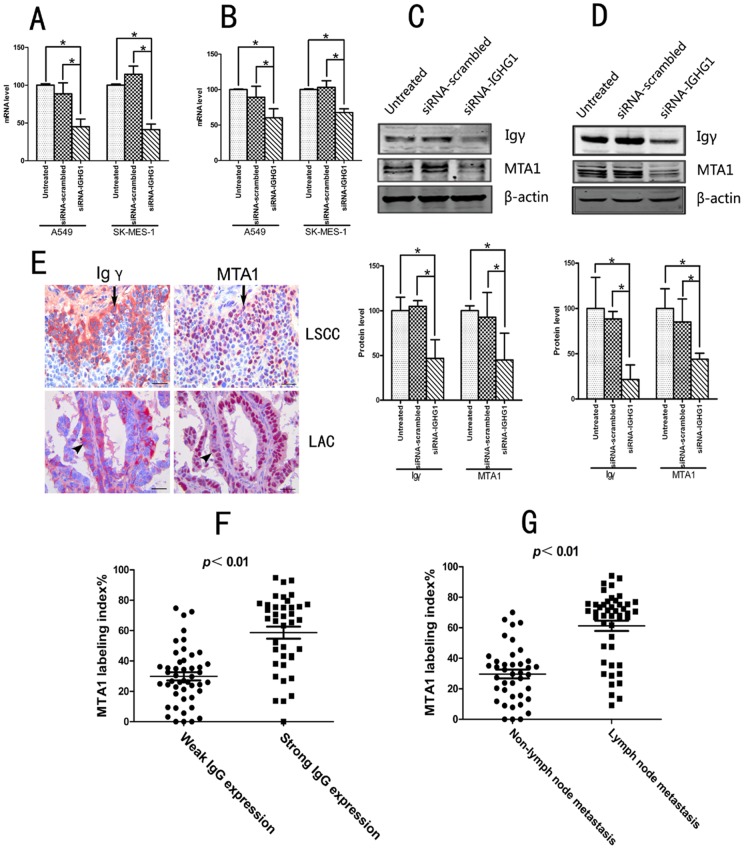
IgG expression was strongly correlated to MTA1 expression and IgG down-regulation lowered MTA1 expression.
A, IgG was down-regulated with specific IGHG1 siRNA transfection with Real-time PCR. B, MTA1 expression was lowered following the decrease of IgG expression detected with Real-time PCR. C, typical bands represent the changes of IgG and MTA1 expressions after IGHG1 siRNA interference in A549 cell line. D, similar changes in SK-MES-1 cell line. E, Igγ (red, positive staining in cytoplasm) was mostly co-localized with MTA1 (purplish red, positive staining in nuclei) in lung cancers. Black arrows or arrowheads show typical cancer cells labeling with IgG and MTA1. F, lung cancers with weak IgG expression have a lower expression level of MTA1 in comparison to strong IgG expression cancers. G, lung cancers with lymph node metastasis have much higher MTA1 expression than non-metastatic cancers. The histograms represent the four independent assays. Data are presented as mean ± S.E. *, p<0.05. Scale bars: 20 µm.